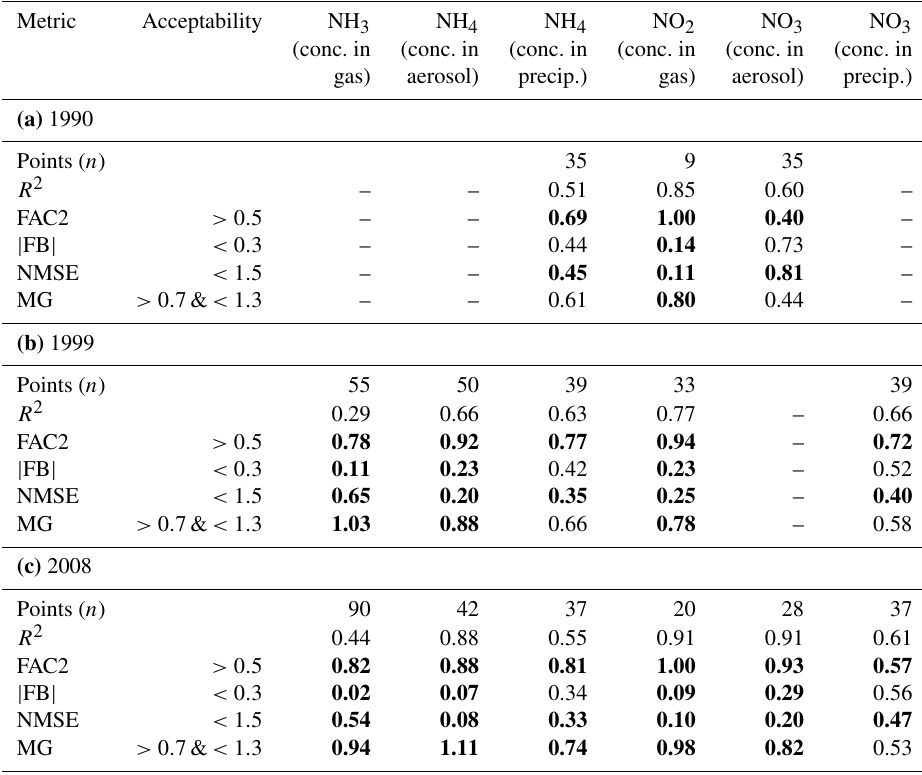
Table 5. Evaluation metrics of modelled concentrations of six nitrogen compounds in the UK for 1990, 1999 and 2008 (see Table 3 for definitions). Dashed lines represent no available data. Bold numbers represent where that metric has been satisfied (see Sect. 2.4.2 for metric